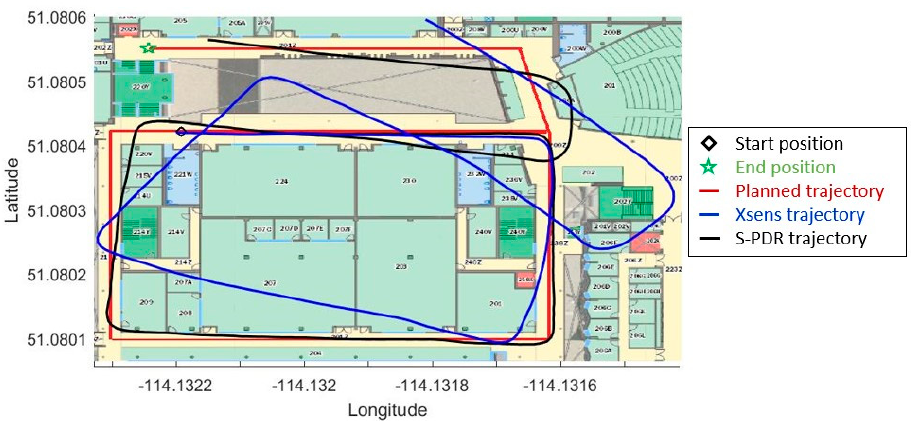
Figure 21. ENG building reference trajectory and reconstructed trajectory using S-PDR and Xsens.